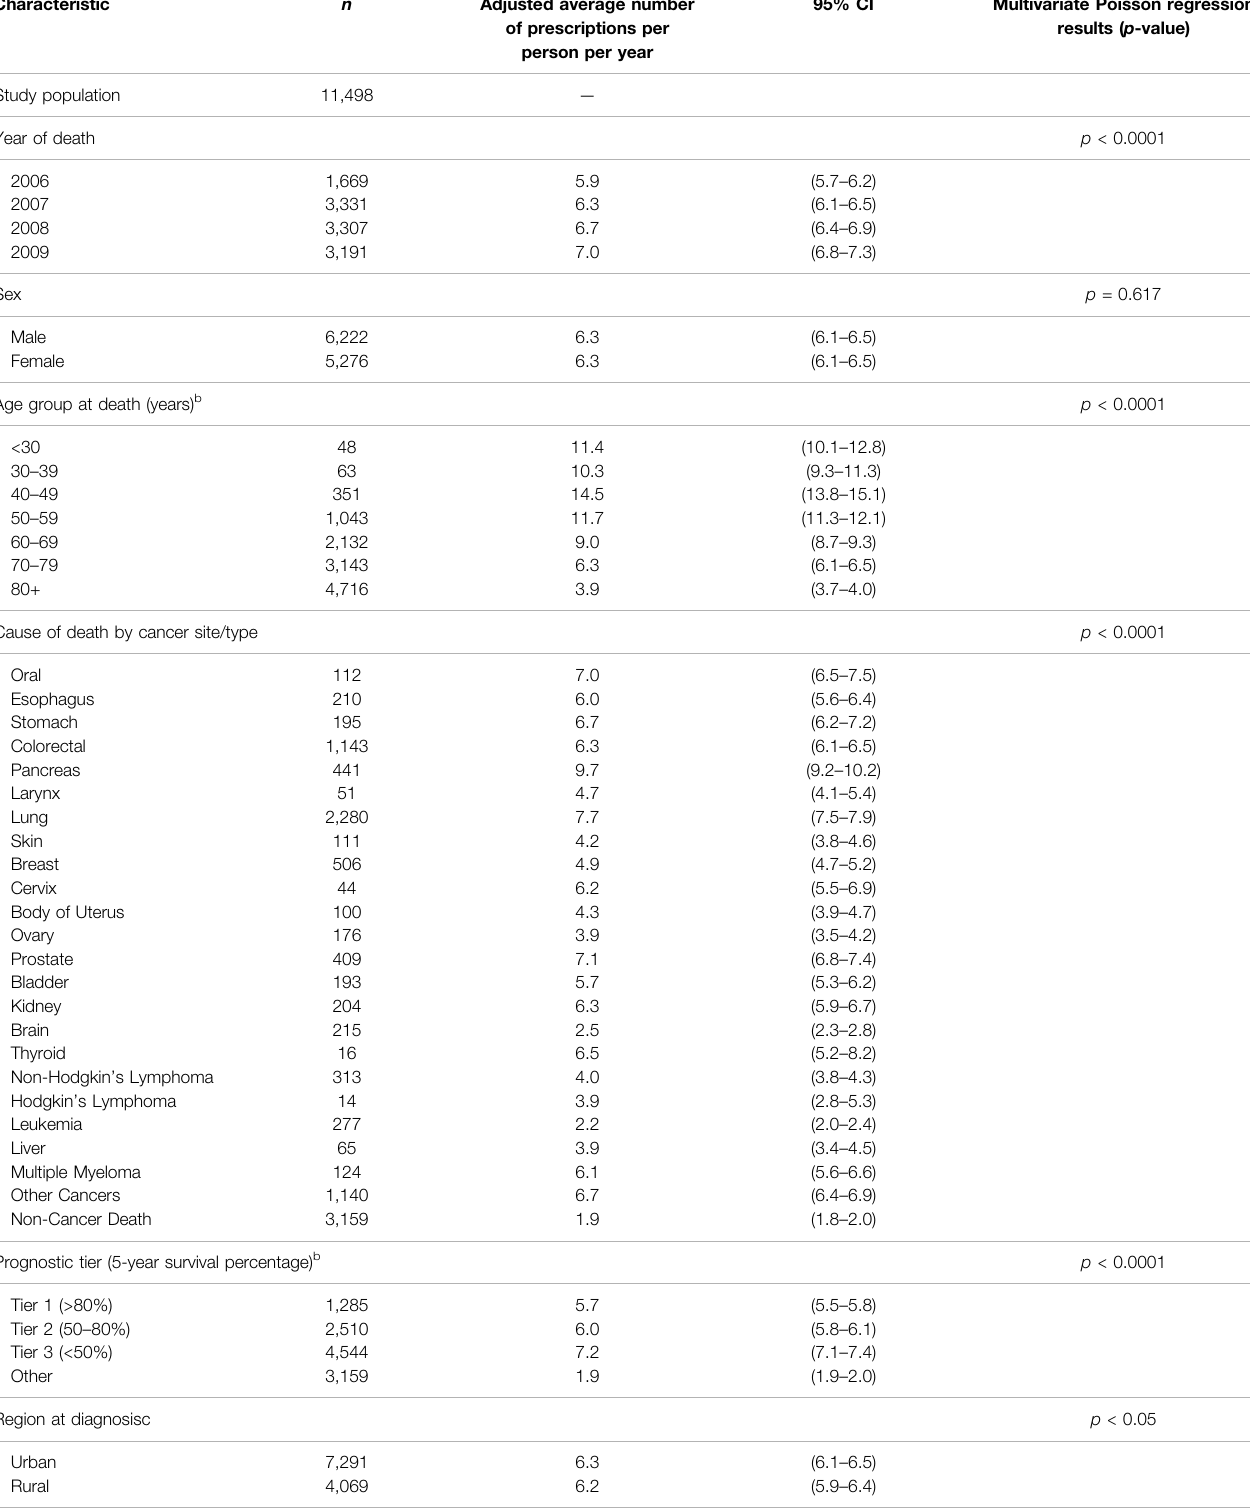
TABLE 3 | Adjusted average rate ofopioid prescriptions a dispensed among the Nova Scotia end-of-life cancer study population from 2005 – 2009 by selected demographic and clinical characteristics ( n = 11,498).